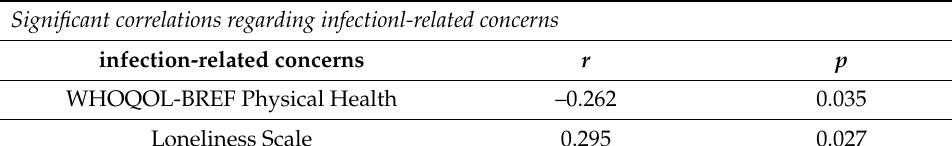
Table 8. Significant correlations regarding pandemic related concerns “No